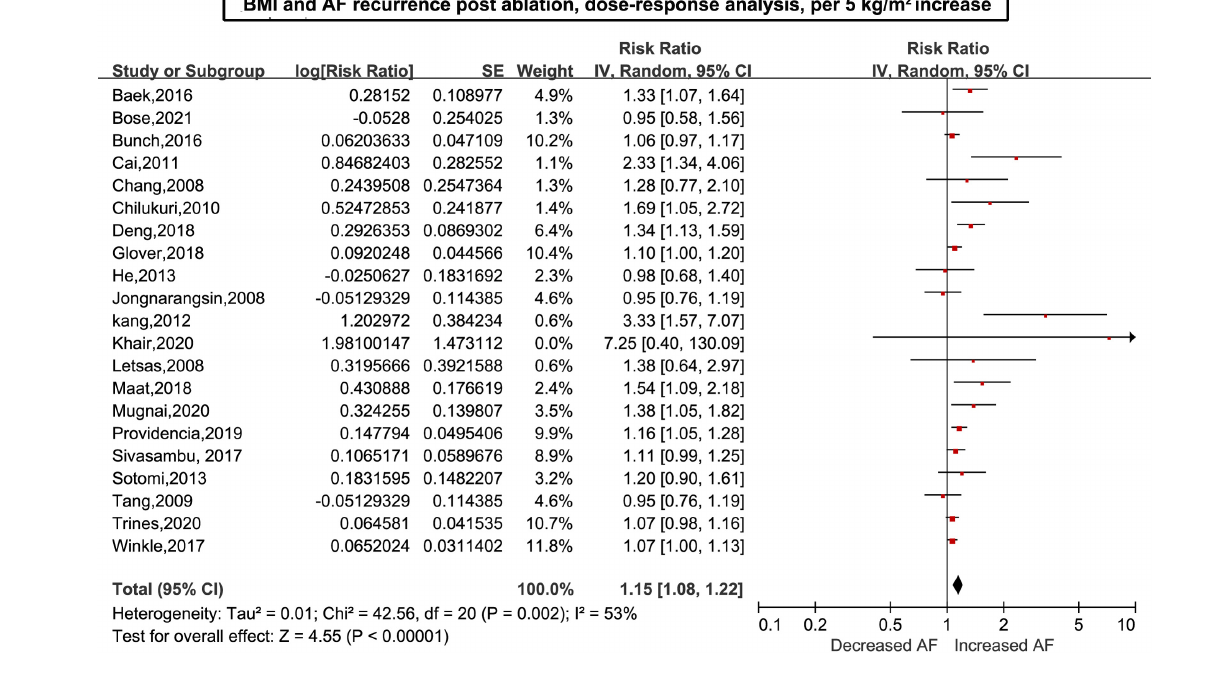
2020 European Society of Cardiology guidelines did not set a BMI threshold value for weight loss in obese patients who plan to receive AF ablation, while our results provide a valuable information for this.